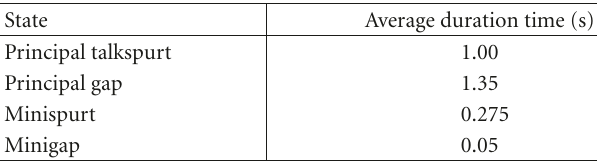
Figure 6: System capacity comparison. Table 2: Voice tra ffi c model